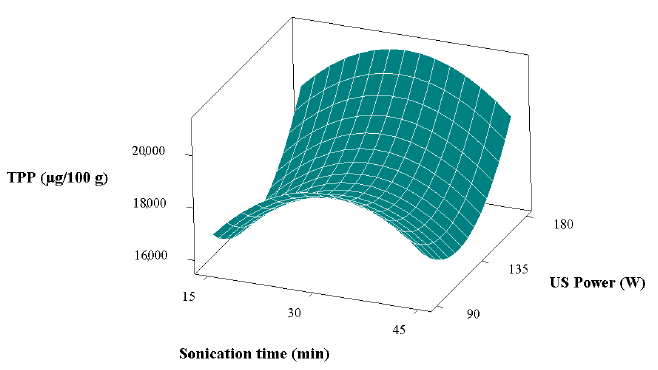
Figure 3. Variation in total individual phenolic compounds (TPP) values with ultrasonic power and sonication time.